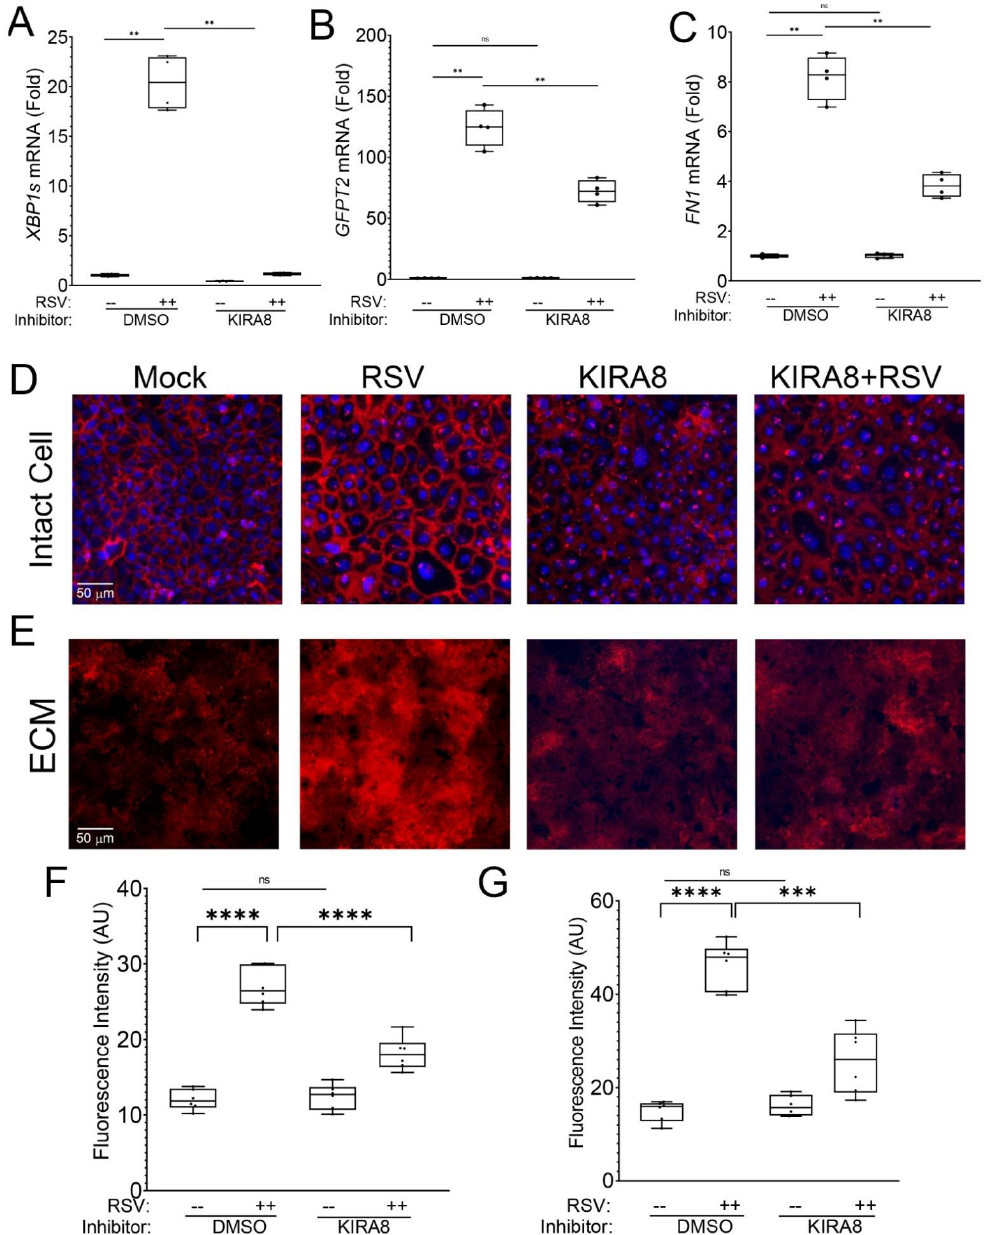
Figure 1. RSV induces ECM remodeling via the IRE1 α –XBP1 arm of UPR. hSAECs were treated with solvent control (DMSO) or KIRA8 (10 µM) and mock- or RSV infected (MOI = 1, 24 h). Total RNA was extracted and analyzed by Q-RT-PCR for ( A ) XBP1 splicing; ( B ) GFPT2 ; and ( C ) FN1. For each graph, fold change mRNA relative to solvent-treated mock-infected cells is shown. ***, p < 0.001; n.s., not significant. ( D ), hSAECs were cultured on PDL-gelatin coated coverslips until confluent, which was followed by treatment with solvent or KIRA8. Cells were then mock or RSV-infected (MOI = 1, 24 h). The cells were fixed and stained for extracellular FN1 without permeabilization. Nuclei were then stained with DAPI. Red, FN1. Blue, DAPI. Scale bar 50 µ m shown. ( E ). Identically treated plates were decellularized and stained for FN1 and imaged. ( F , G ), Quantitation of the FN1 fluorescence intensity by FIJI. The data points and mean from three independent experiments are presented. **, p < 0.01; ***, p < 0.001; ****, p < 0.0001; n.s., not